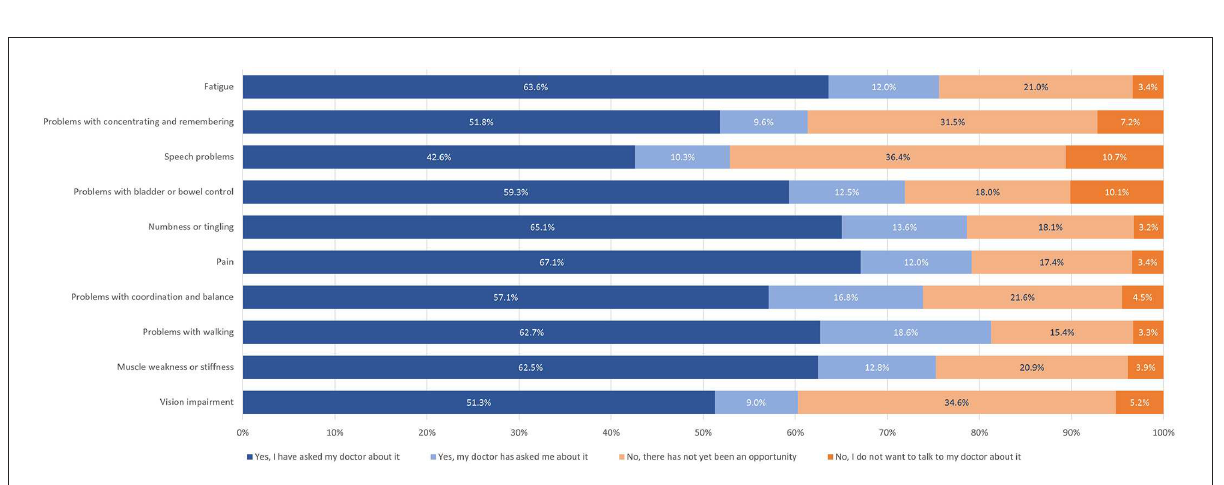
FIGURE2 Reporting of symptoms worsened in the last 12 months independent of